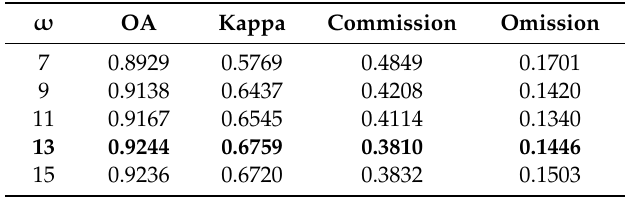
Table 6. Accuracy under di ff erent patch sizes on the second dataset.